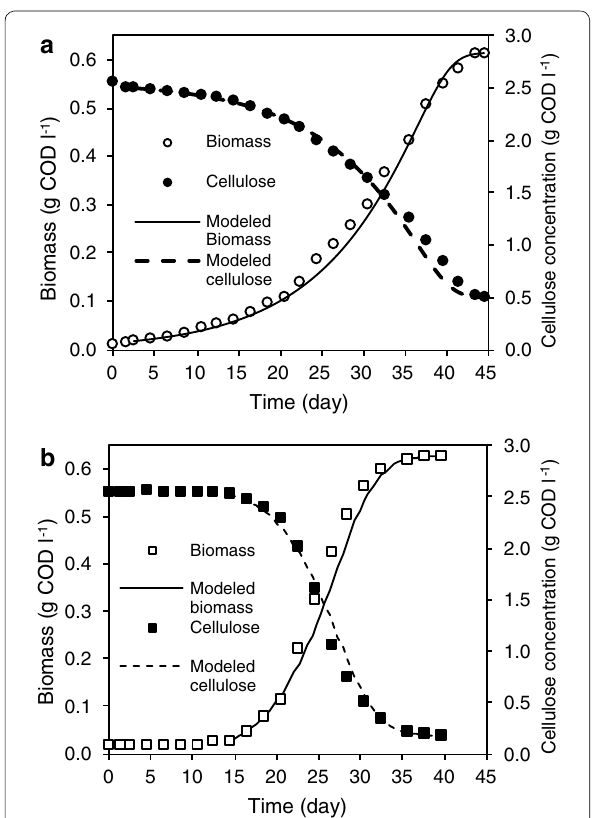
Fig. 3 Experimental and modeled growth kinetics. a Mono‑culture. b